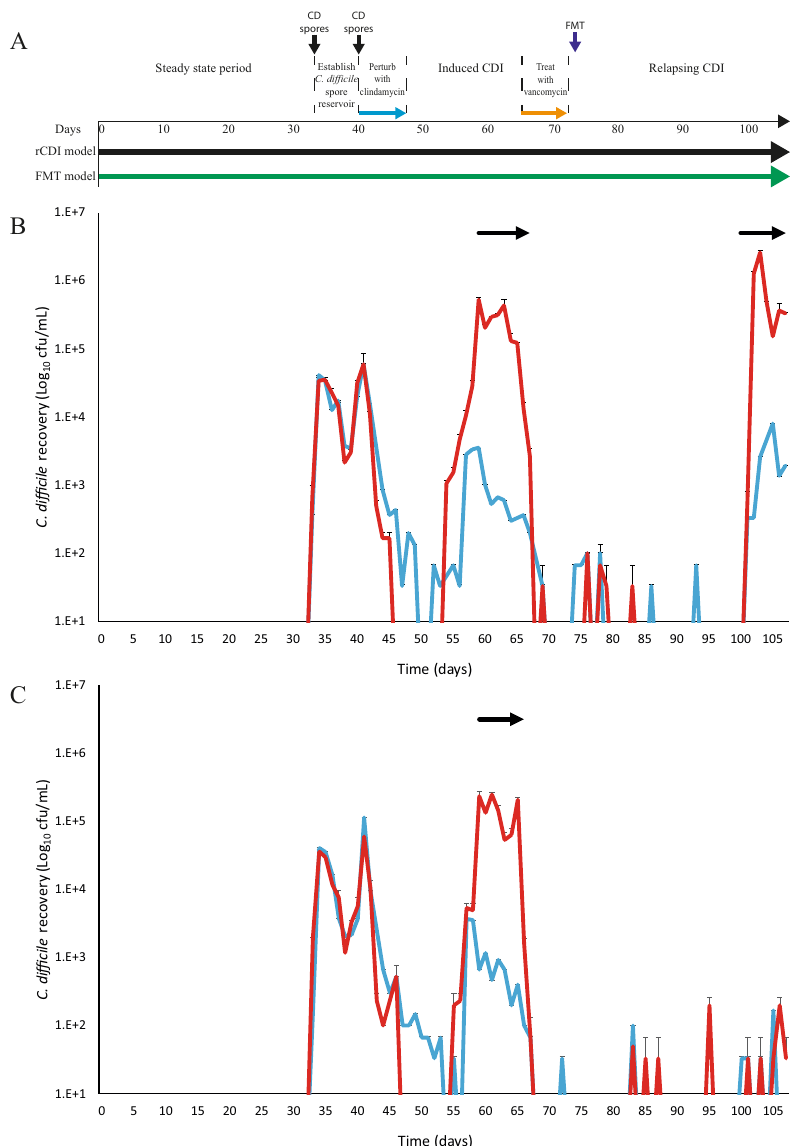
Fig. 1 Ef fi cacy of FMT to treat simulated recurrent CDI. A Timeline of two in vitro chemostat models that were used to simulate primary CDI and recurrence after vancomycin treatment (black) and vancomycin treatment followed by FMT instillation (green). Luminal C. dif fi cile recoveries from the recurrence model ( B ) and from FMT model ( C ). Both fi gures show the total viable counts (red lines), spores (blue lines) and period of toxin detection (black arrows). Results are shown as mean log 10 cfu/mL from two biological replicates, and three technical replicates from each. Error bars represent the standard